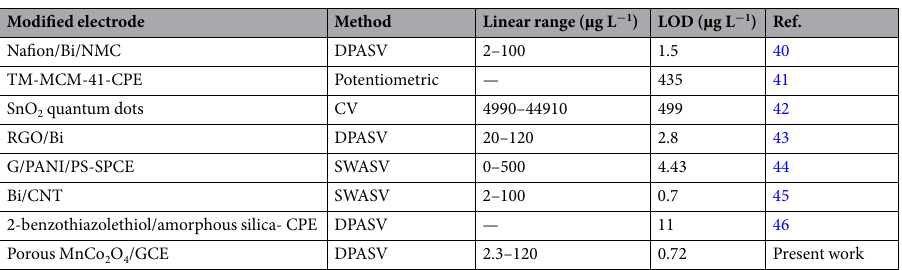
Table 1. Comparison for the analytical performance of other reported methods. NMC- Nitrogen doped microporous carbon, TM-MCM- Thiomorpholine-functionalized-Mobil Composition Matter, CPE- carbon paste electrode, RGO- Reduced graphene oxide, G/PANI/PS-Graphene/polyaniline/polystyrene nanoporous fibers, CV- Cyclic Voltammetry, DPASV-Differential pulse anodic stripping voltammetry, SWASV-Square-wave anodic stripping